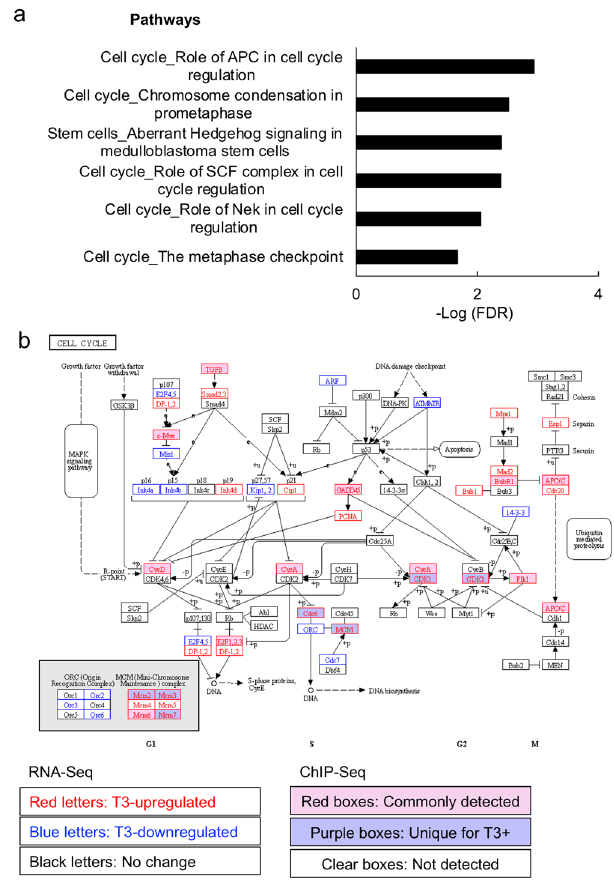
Fig. 6 TR α -dependent enrichment of cell cycle pathways among genes bound by TR in the wild-type intestine. a Top 10 cell cycle pathways differentially enriched among genes bound by TR in wild-type intestine. The pathways that were enriched among genes bound by TR in the wild-type intestine (Supplementary Data 6) were subtracted by the pathways that were enriched among genes bound by TR in TR α − / − intestine (Supplementary Data 12) to obtain the pathways only enriched in the wild- type intestine (Supplementary Data 14). The most signi fi cant 10 cell cycle- related pathways were plotted here (see Supplementary Data 20 for raw data). b TR-binding and regulation of genes in the pathway for cell cycle based on ChIP-Seq and RNA-Seq data. The pathway for cell cycle was visualized with regard to genes regulated by T3 based on RNA-Seq and/or bound by TR based on ChIP-Seq. The arrows show functional interaction: green for activation. Letters in red and blue indicate upregulated and downregulated genes, respectively, in wild-type intestine after T3 treatment. Letters in black indicate genes with no change in wild-type intestine after T3 treatment. Red boxes indicate ChIP-Seq detected genes both with and without T3 treatment, and purple boxes indicate genes identi fi ed by ChIP-Seq only in wild type with T3 treatment. Note that Cyclin A and CDK1 were among the genes directly bound by TR and upregulated by T3. and signi fi cant cell proliferation occurs only after 3 days of T3 treatment 19 . These fi ndings suggest that the activation of cell cycle and proliferation pathways is an early event important for larval cell death. Further support for this came from comparisons between the wild-type and TR α − / − intestine. First, there were many more cell cycle/proliferation-related GO terms and path- ways enriched among TR-bound genes in the wild-type intestine (Supplementary Data 5, 6) than those enriched among TR-bound genes in the TR α − / − intestine (Supplementary Data 11, 12) (see